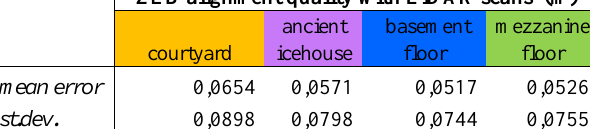
Table 3. Results of ZebRevo clouds registration.